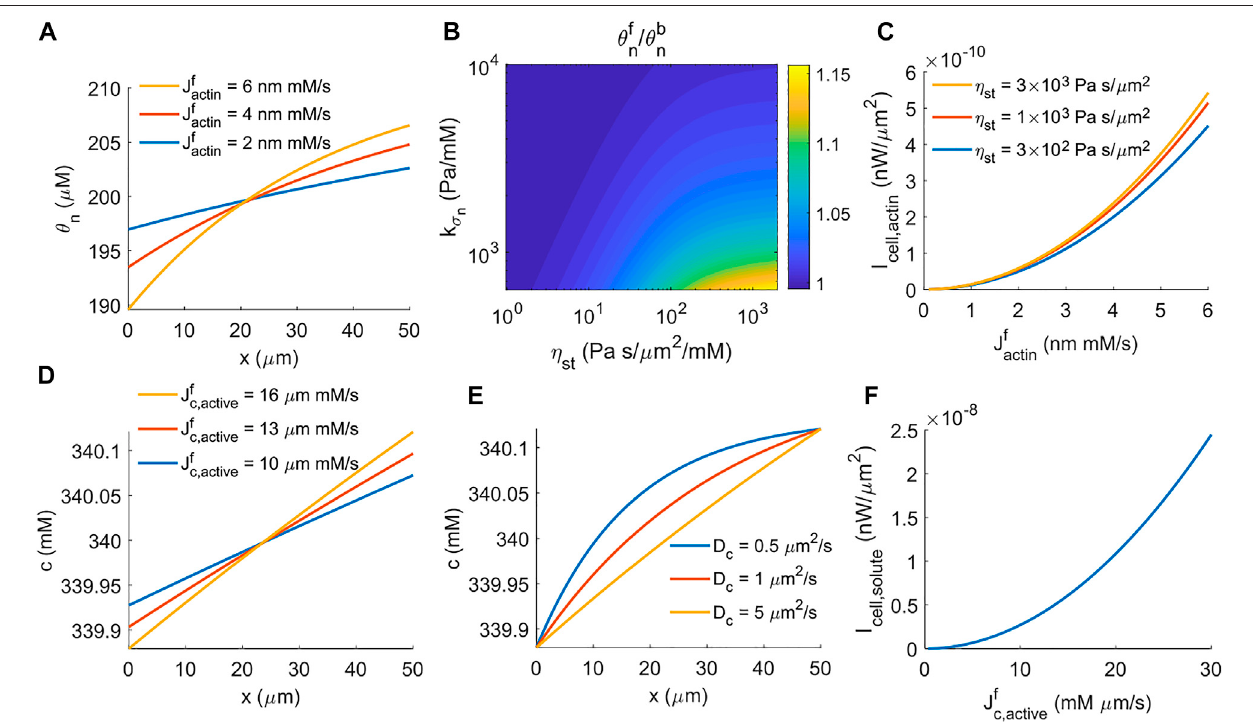
FIGURE 2 | Energy generated by cells under actin-driven and water-driven cell migration. (A) Spatial distribution of F-actin concentration for different rates of actin polymerization. (B) ThecontouroftheF-actin concentrationratioatthefront and backofthecell, θ f n / θ b n ,asafunctionoftheactinpressurecoef fi cientand focaladhesion strength. θ f n (cid:2) θ n | x (cid:2) L − and θ b n (cid:2) θ n | x (cid:2) 0 + . (C) Power generation from the actin network as a function of the rate of actin polymerization, J f actin , for different strengths of focal adhesion. (D) Spatial distribution of solute concentration for different rates of active solute fl ux. (E) Spatial distribution of solute concentration for different coef fi cients of diffusion. (F) Power generation from the active solute pumping as a function of the rate of active solute fl ux, J f c , active .